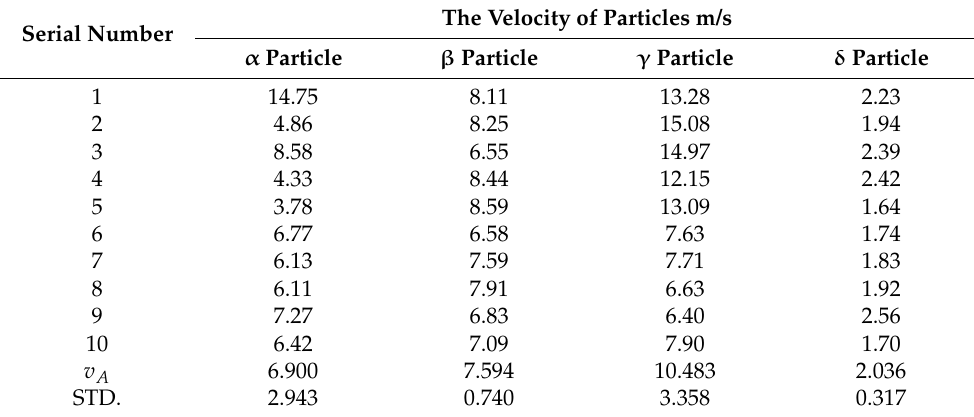
Table 3. Four types of particle velocity of specimen